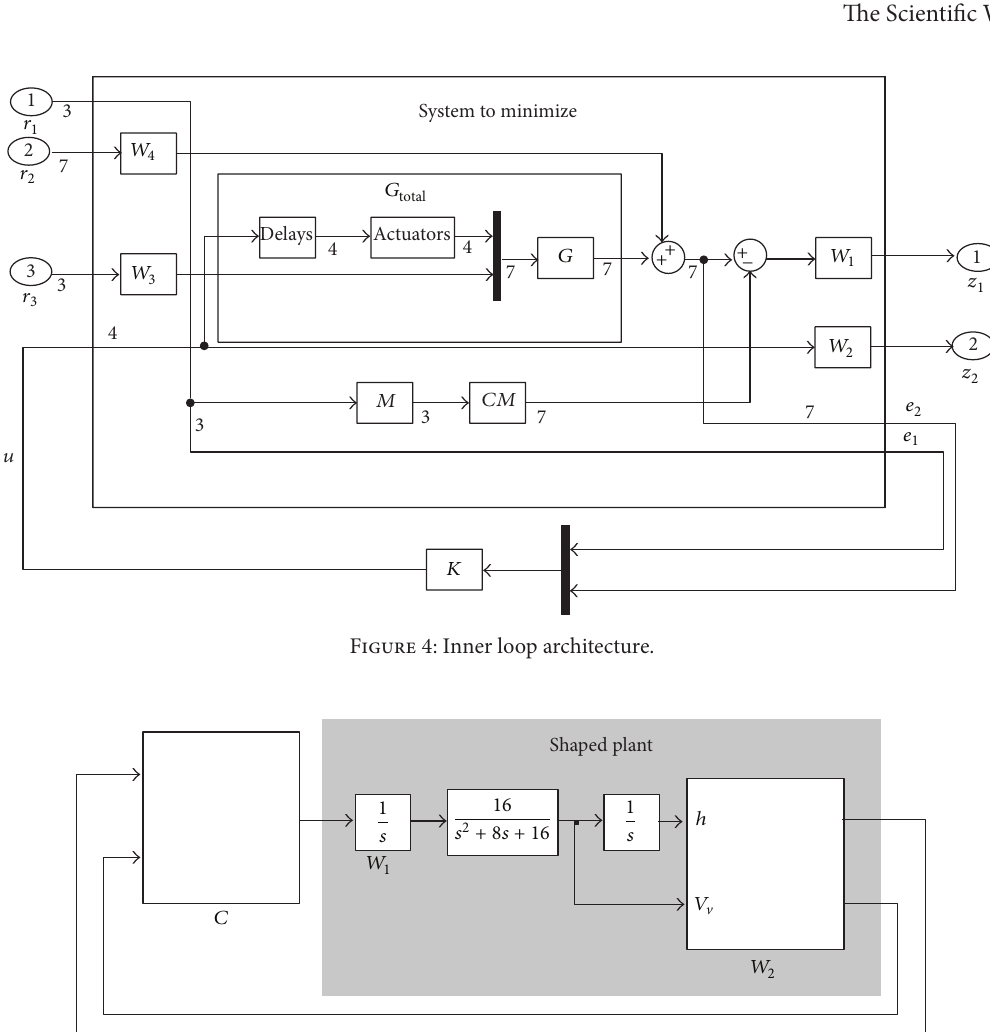
Figure 5: Outer-loop altitude command